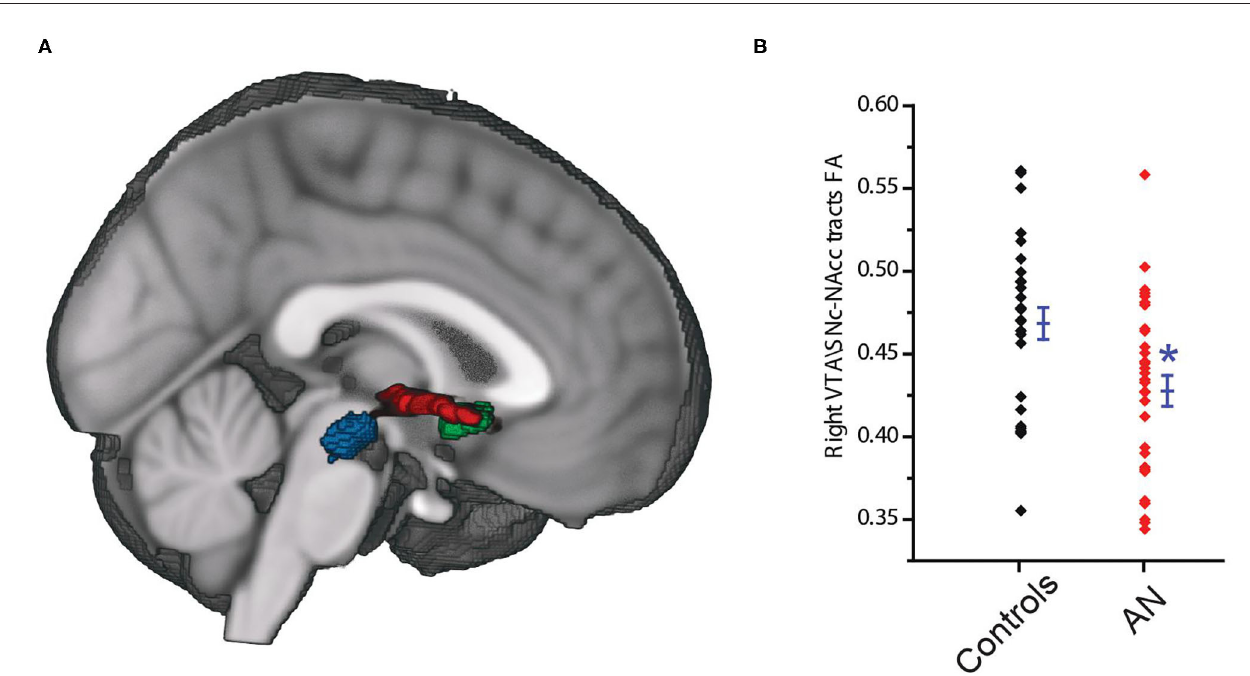
FIGURE 4 | The VTA \ SNc (blue) and the NAcc (green) regions of interest, and the connecting white matter tracts (red) (A) . Tracts connecting the right VTA \ SNc and right NAcc ROIs showed significantly lower lower average fractional anisotropy (FA) in the AN compared to control group (B) . The * symbol indicates statistically